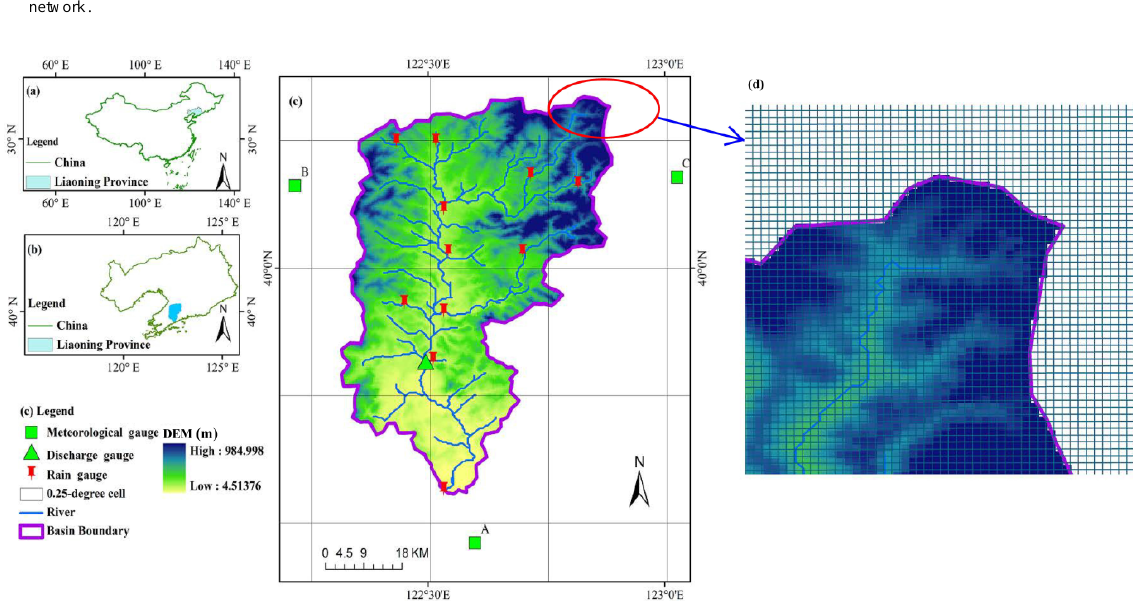
Figure 1. Biliu basin: (a) the location of Liaoning province within China; (b) the location of Biliu basin within Liaoning province; (c) the distributions of rain gauges, discharge gauge, automatic weather stations, digital elevation model, and diagrammatic 0.25 ◦ precipitation cells; and (d) diagrammatic description of downscaling the 0.25 ◦ precipitation cells to 300m × 300m cells, and retrieving the 300m × 300m cells located within the basin